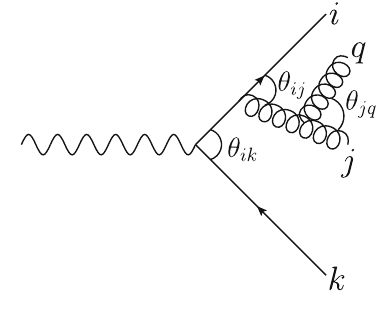
Fig. 1 One of the Feynman diagrams contributing to the O (α 2 s ) e + e − → q ¯ qgg matrix element used to compute Eq. (1). In the present work we calculate these in the soft approximation for which the second gluon is assumed to have energy much less than the first emission